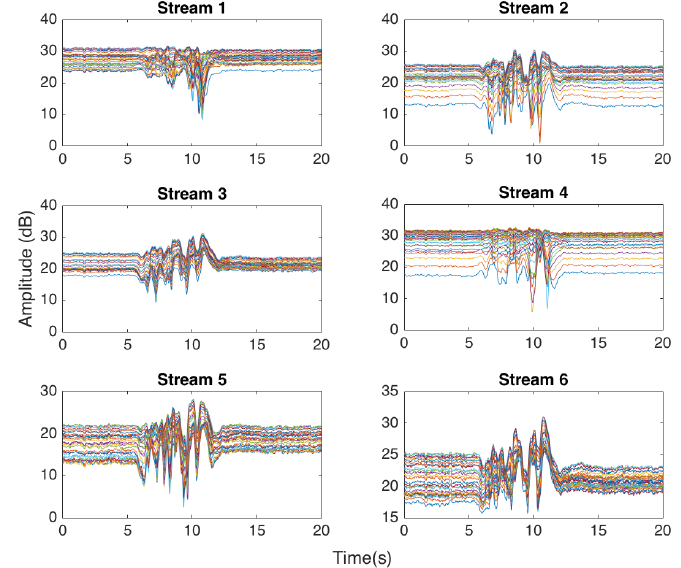
Figure 3. Thirty subcarriers of each